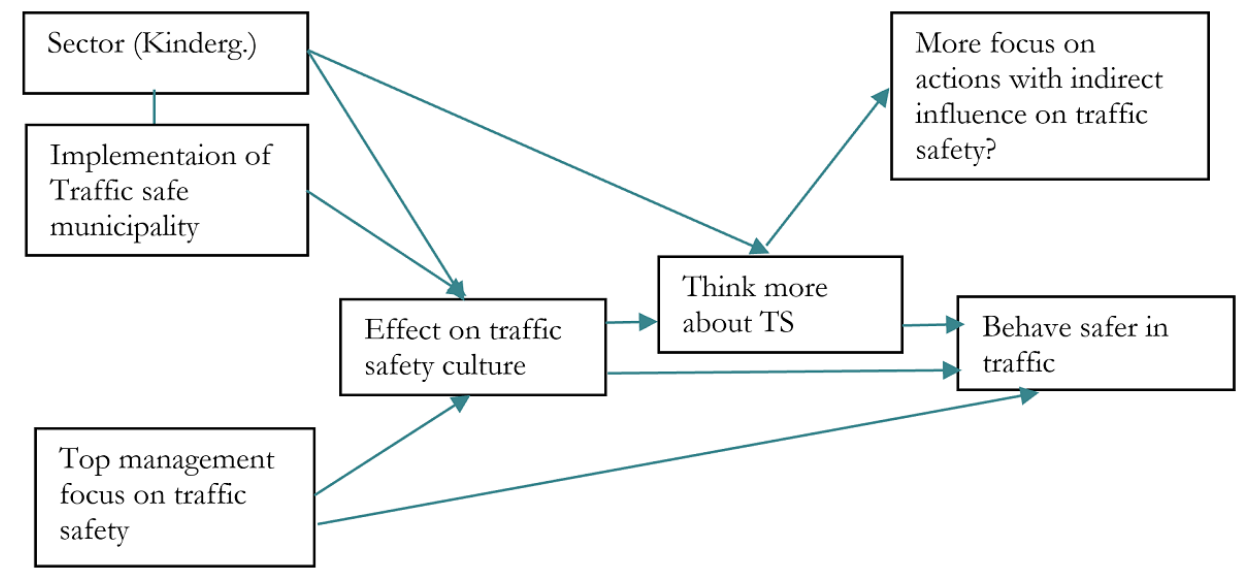
Figure 1 Illustration of relationships between implementation of Traffic Safe Municipality, perceived effects on traffic safety culture, reported changes in respondents’ own focus on traffic safety and reported changes in traffic